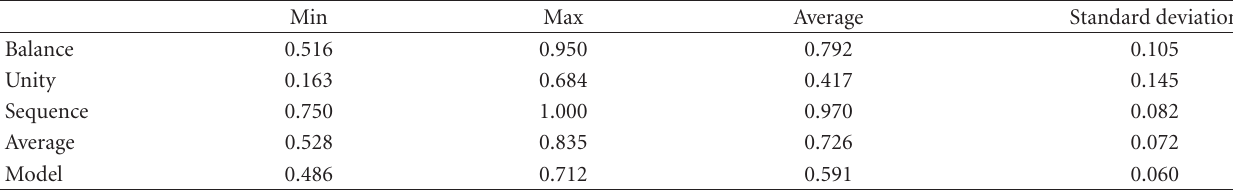
Figure 3: An Example of how a web page is divided into visual objects ((a) shows the original web page; (b) shows the page divided into visual objects). Table 5: Descriptive statistics for the measures and the model for the 42 web pages.